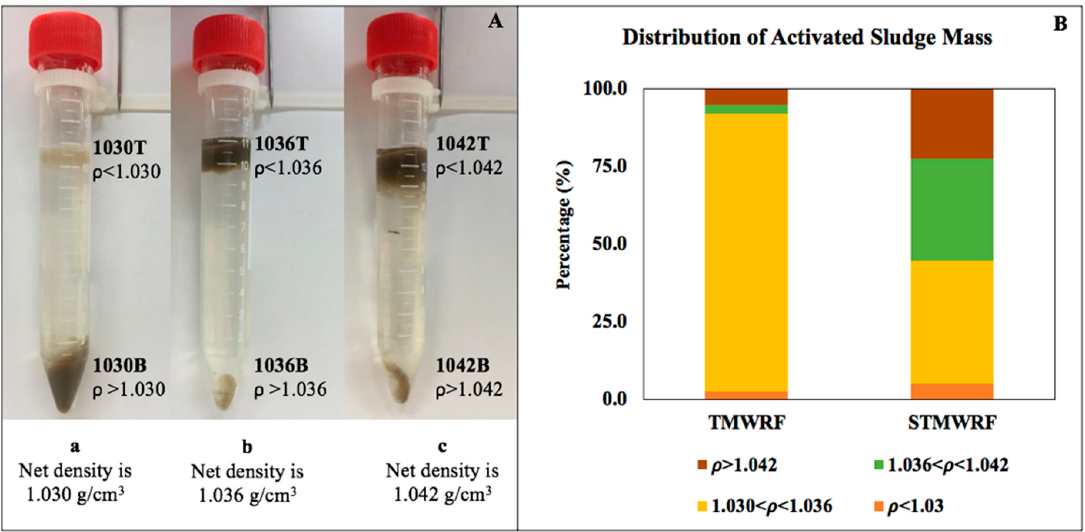
Figure 1. Density-based homogeneous separation of AS biomass. ( A ) A visualization of separation of AS from the EBPR facility TMWRF, using three density suspensions a, b and c as detailed in Table 1. AS was separated into two fractions, either lighter (e.g., 1030T) or denser (e.g., 1030B) than the net density of the suspension (e.g., 1.030 g / cm 3 for the density suspension a). ( B ) Mass distribution of AS from an aeration tank in the EBPR facility TMWRF and from an oxidation ditch with nitrogen removal function in STMWRF performing conventional treatment.